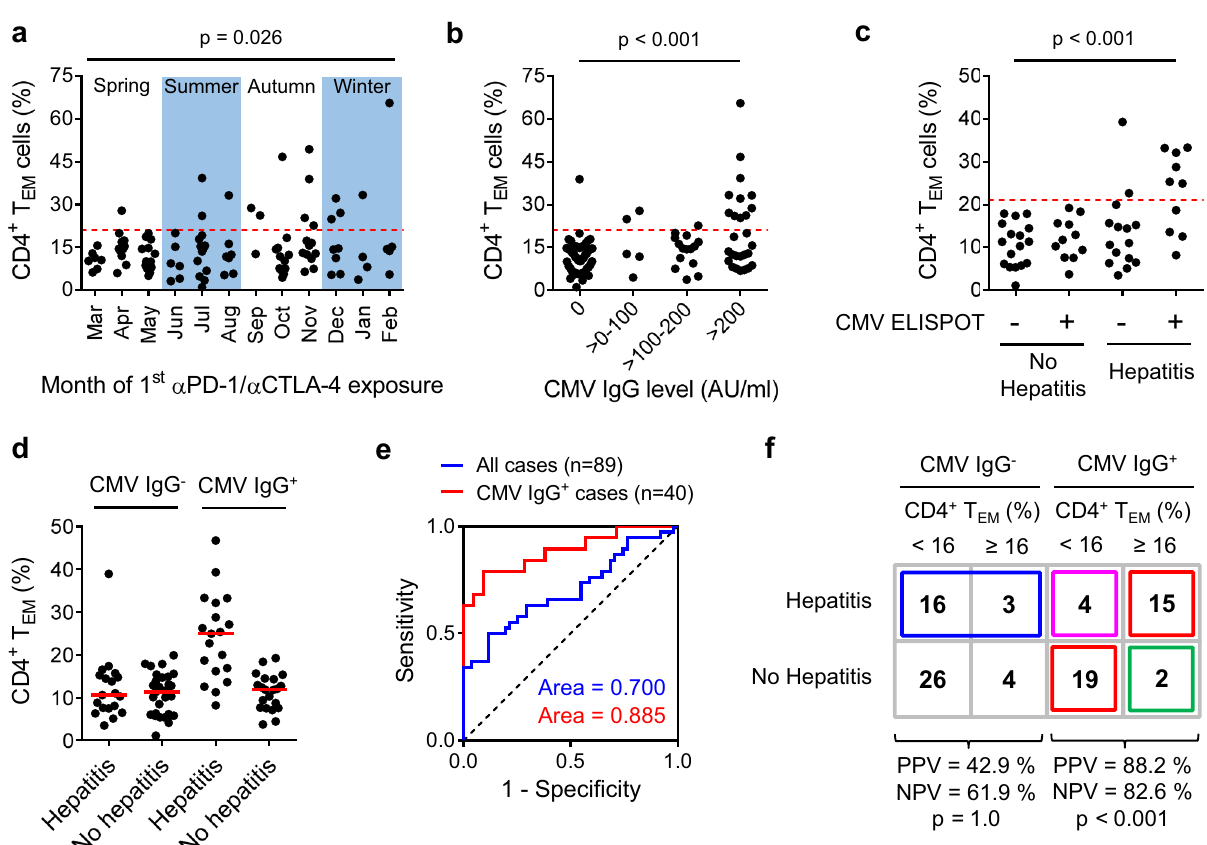
Fig. 5 CD4 + T EM cell expansion correlates with immunity to cytomegalovirus. a Seasonal presentation of CD4 + T EM ≥ 21% patients between 2017 and 2020 ( n = 103; F.E.). Dashed red line indicates a cut-off of CD4 + T EM ≥ 21%. b CD4 + T EM ≥ 21% status was associated with high serum levels of